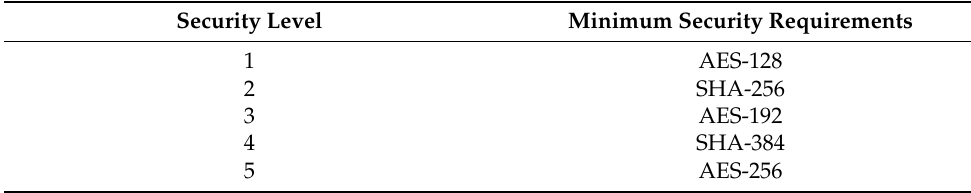
Table 1. NIST security levels in the PQC standardization process as defined in